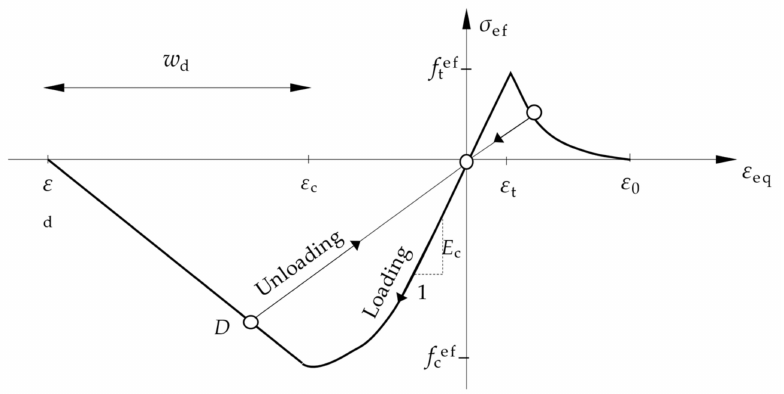
Figure 5. Standardized stress–strain relationship.